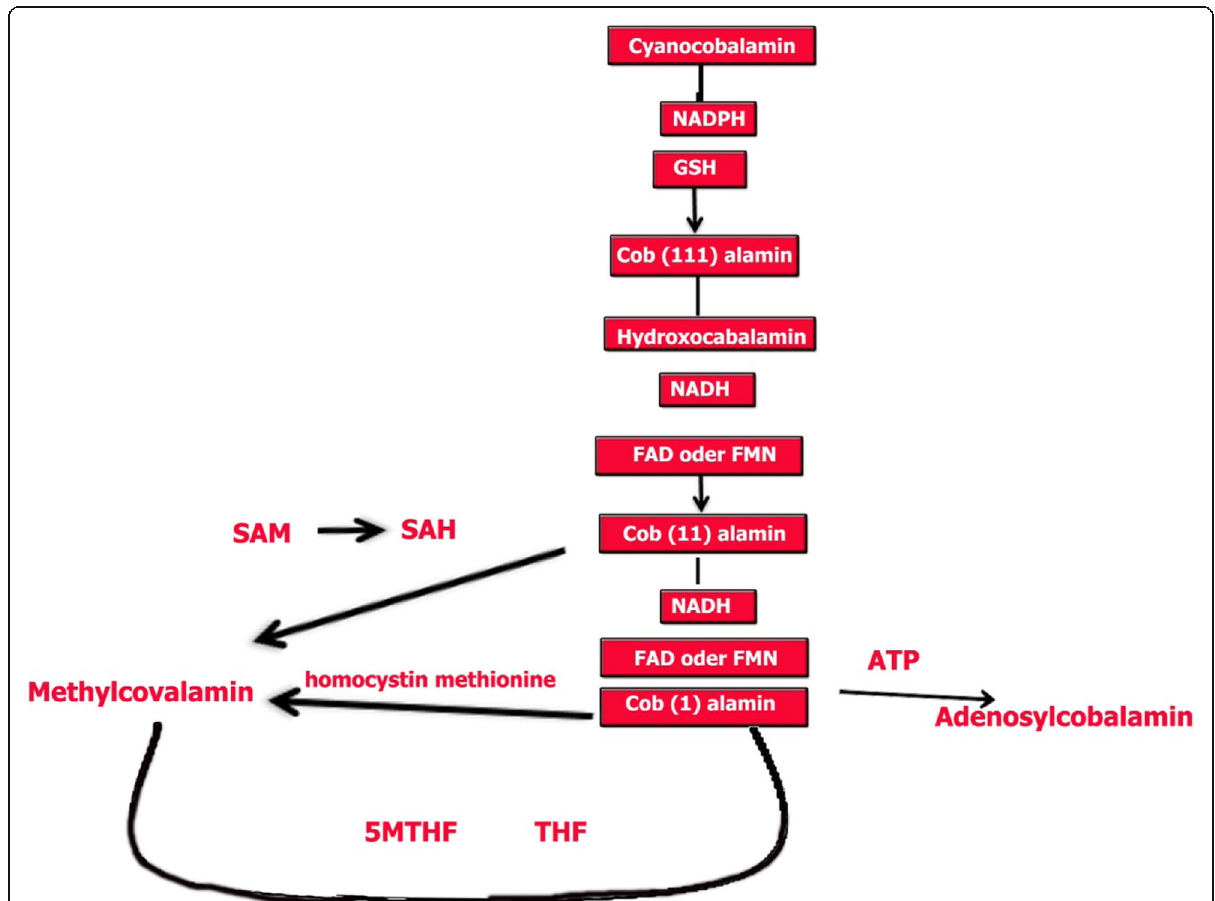
Fig. 1 Convertible forms of vitamin B 12 in human